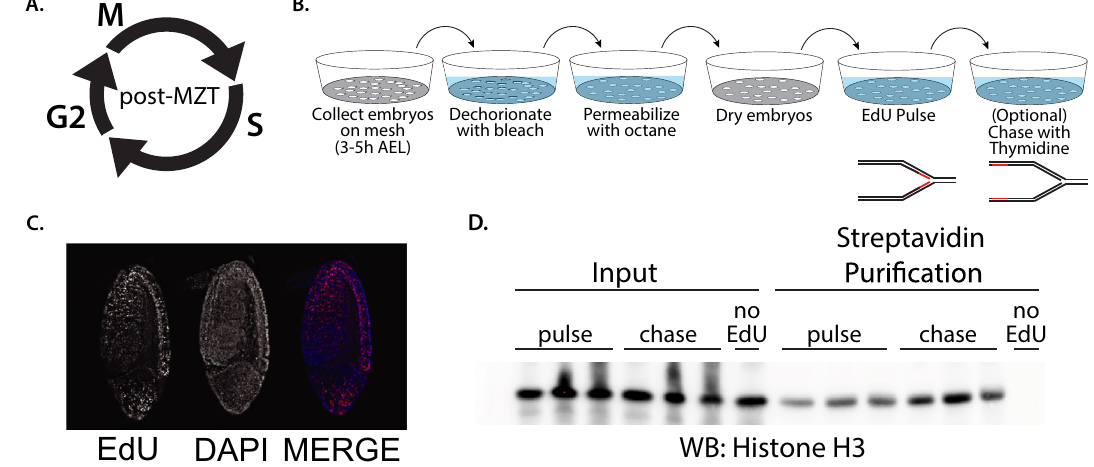
Figure 1. Establishing iPOND in the developing embryo. ( A ) A schematic of the rapid cell cycle in post- MZT embryos (3–5 h AEL). ( B ) Experimental design for large-scale EdU labeling of embryos for iPOND. ( C ) Representative image of an EdU-labeled post-MZT embryo used for iPOND purifications. Embryo labeling was deemed successful if > 50% of the embryos were uniformly labeled. ( D ) Western blot of three biological replicates for pulse and chase iPOND samples with a no EdU pulse control. Anti-H3 antibody is used as a marker of total chromatin